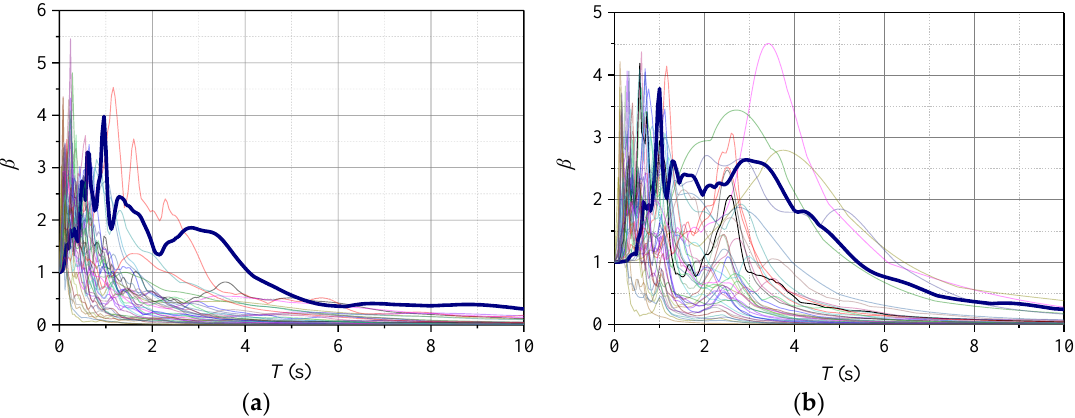
Figure 13. Acceleration response spectra of ( a ) bedrock ground motion records and ( b ) computed ground surface acceleration time histories.